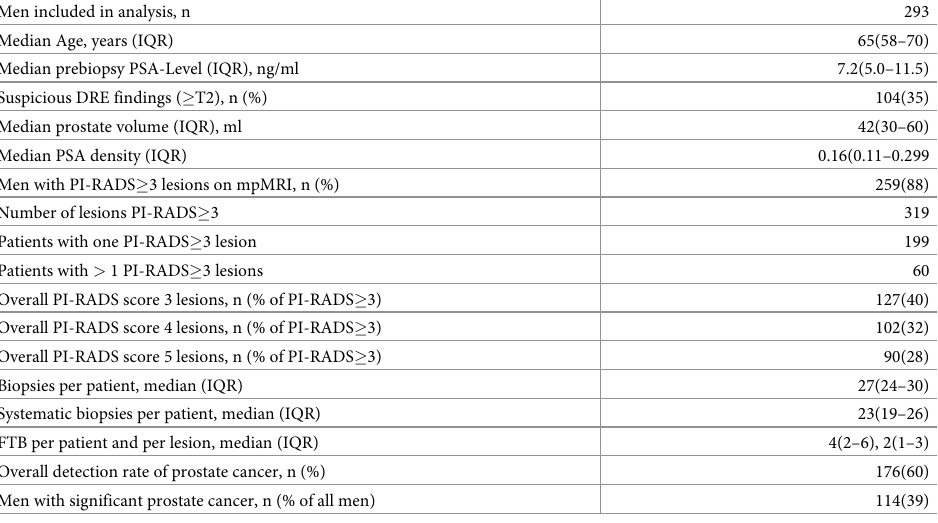
Table 1. Study population and results according to START criteria. Patients’ demographics including baseline clin- ical parameters, MRI and MRI/TRUS-fusion biopsy results according to START criteria. Men included in analysis,